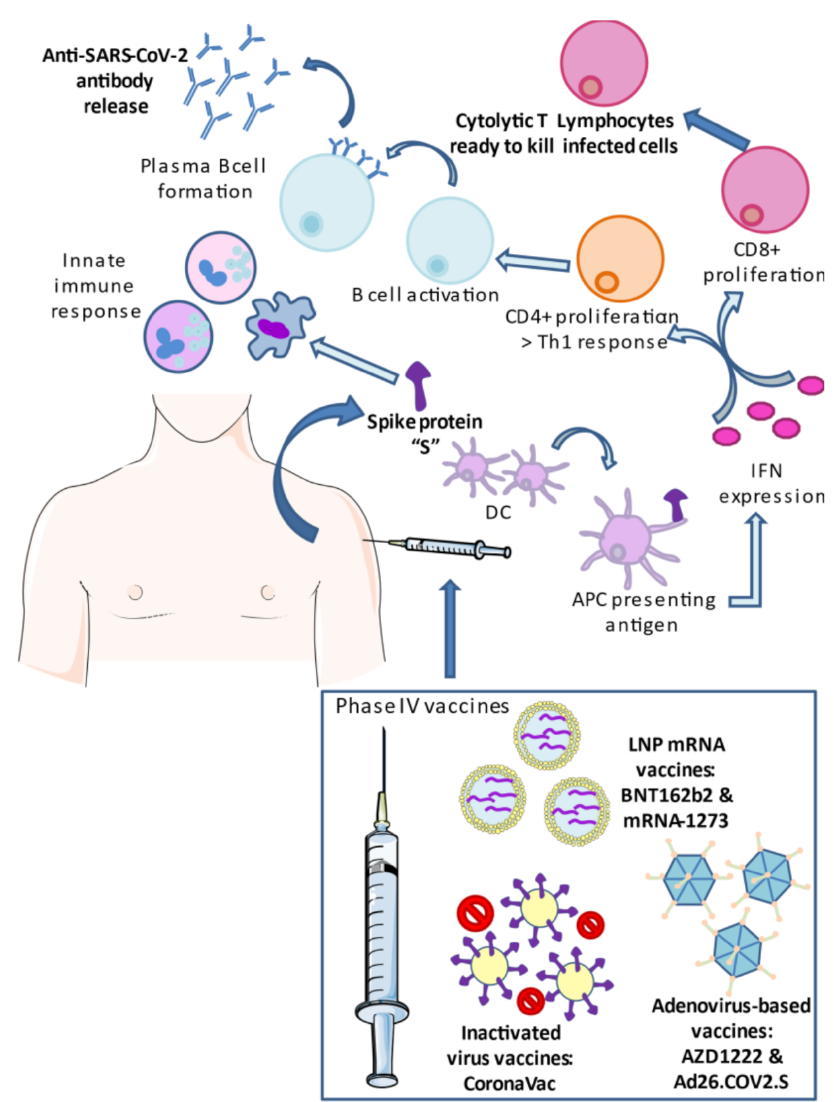
Figure 2. Designs of, and immune reactions promoted by, COVID-19 vaccines. mRNA-based, adenoviral vectors, or inactivated virus can induce a coordinated innate and adaptive response, prominently limiting the damage caused by SARS-CoV-2 infection. In all cases, the recognition of the spike protein activates the innate immune system and interferon pathways, showing antiviral properties, promoting T and B cell responses, with an augmentation of cytolytic T cells and antibodies secreted against